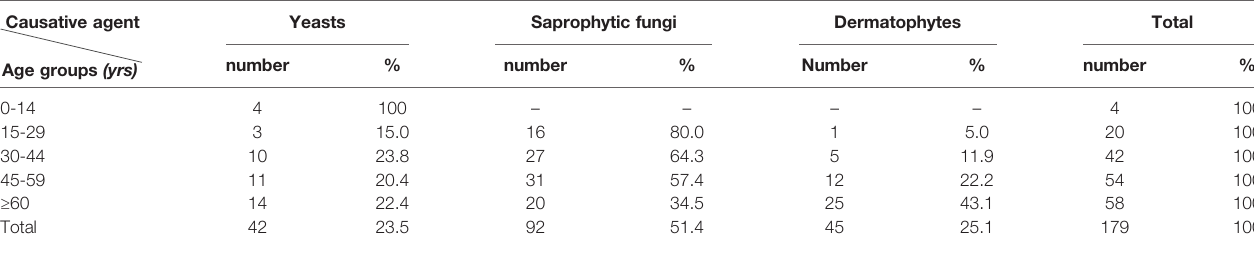
TABLE 1 | The frequency of causative agents of onychomycosis in regard to age groups. Causative agent Age groups